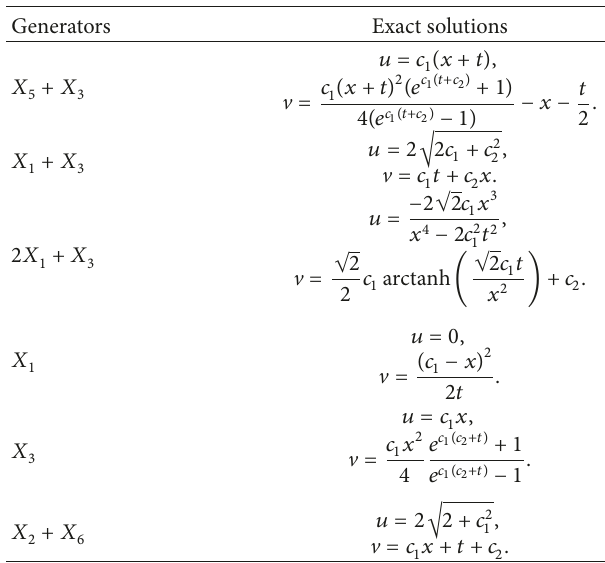
Table 3: Exact solutions of the two-component Chaplygin gas